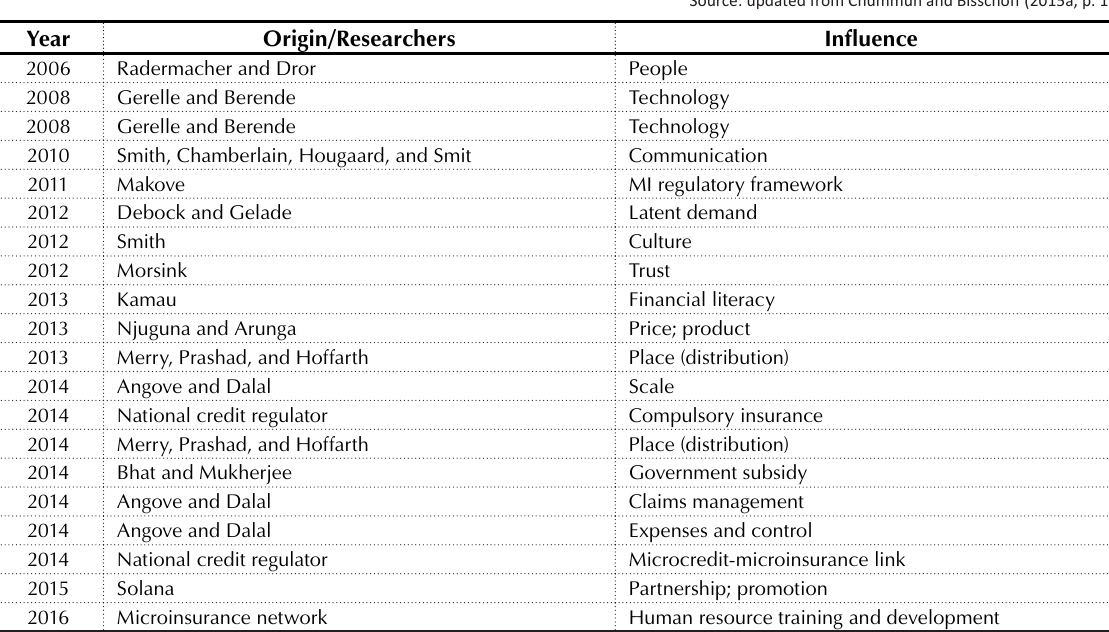
Table 1. Business success influences in